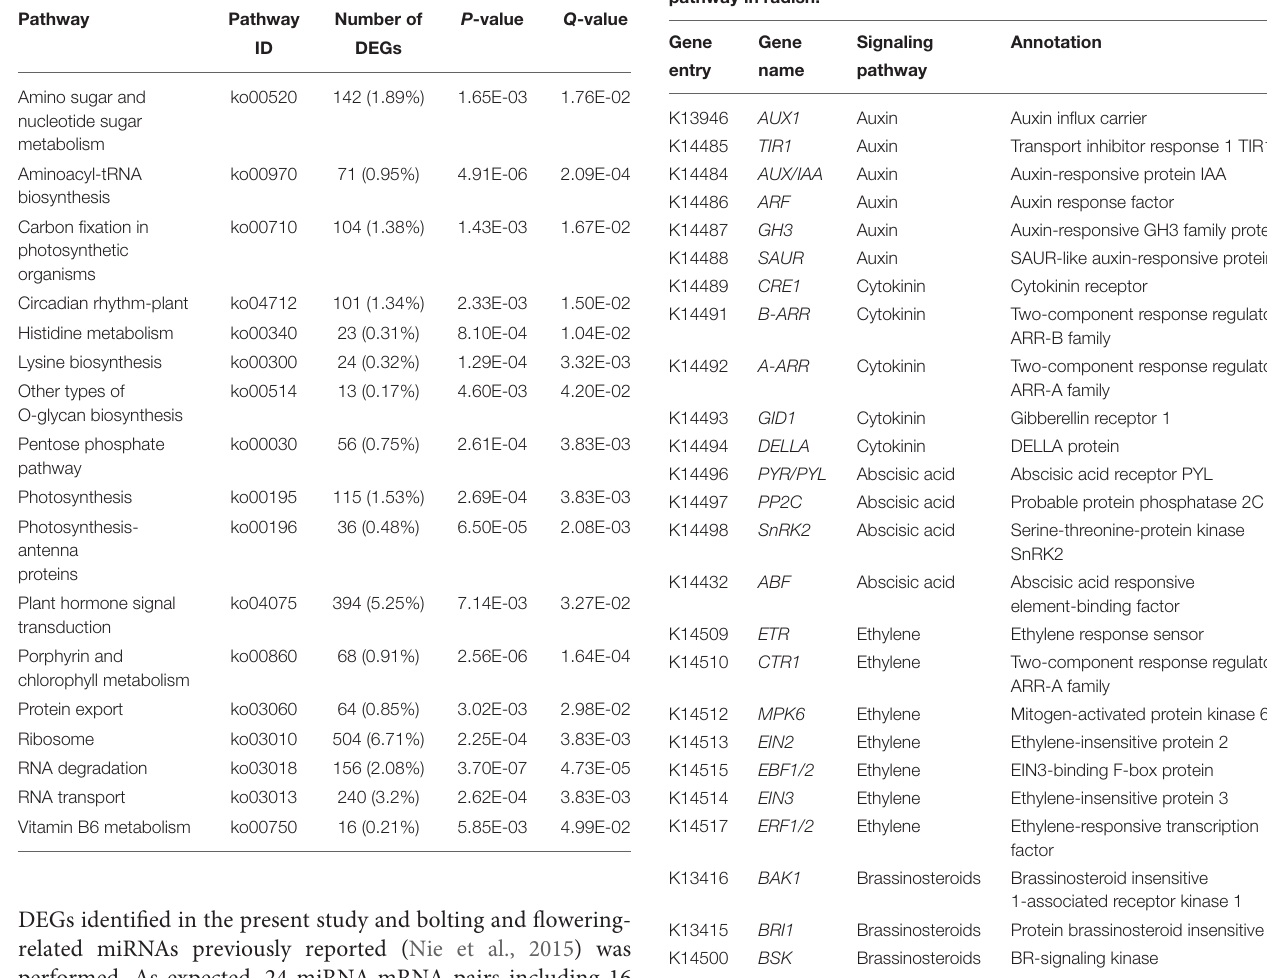
TABLE 2 | The significantly enriched pathways for DEGs in radish. TABLE 3 | The identified DEGs involved in hormone signal transduction